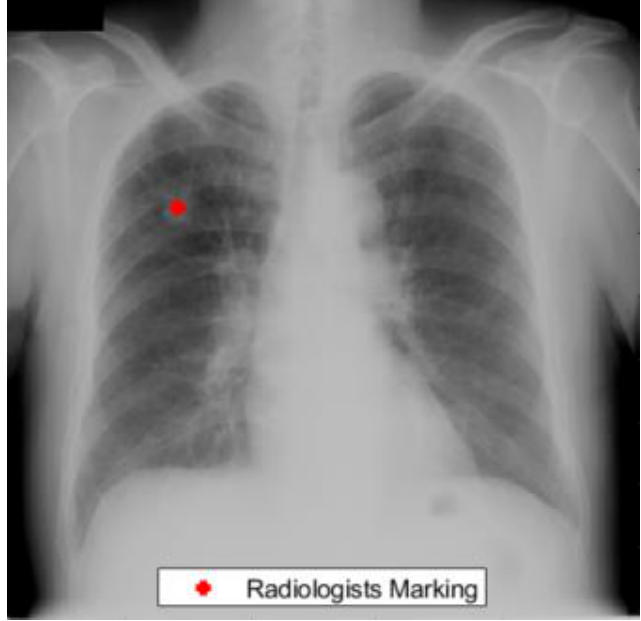
Figure 1. An example from the JRST dataset with a radiologist nodule marking.